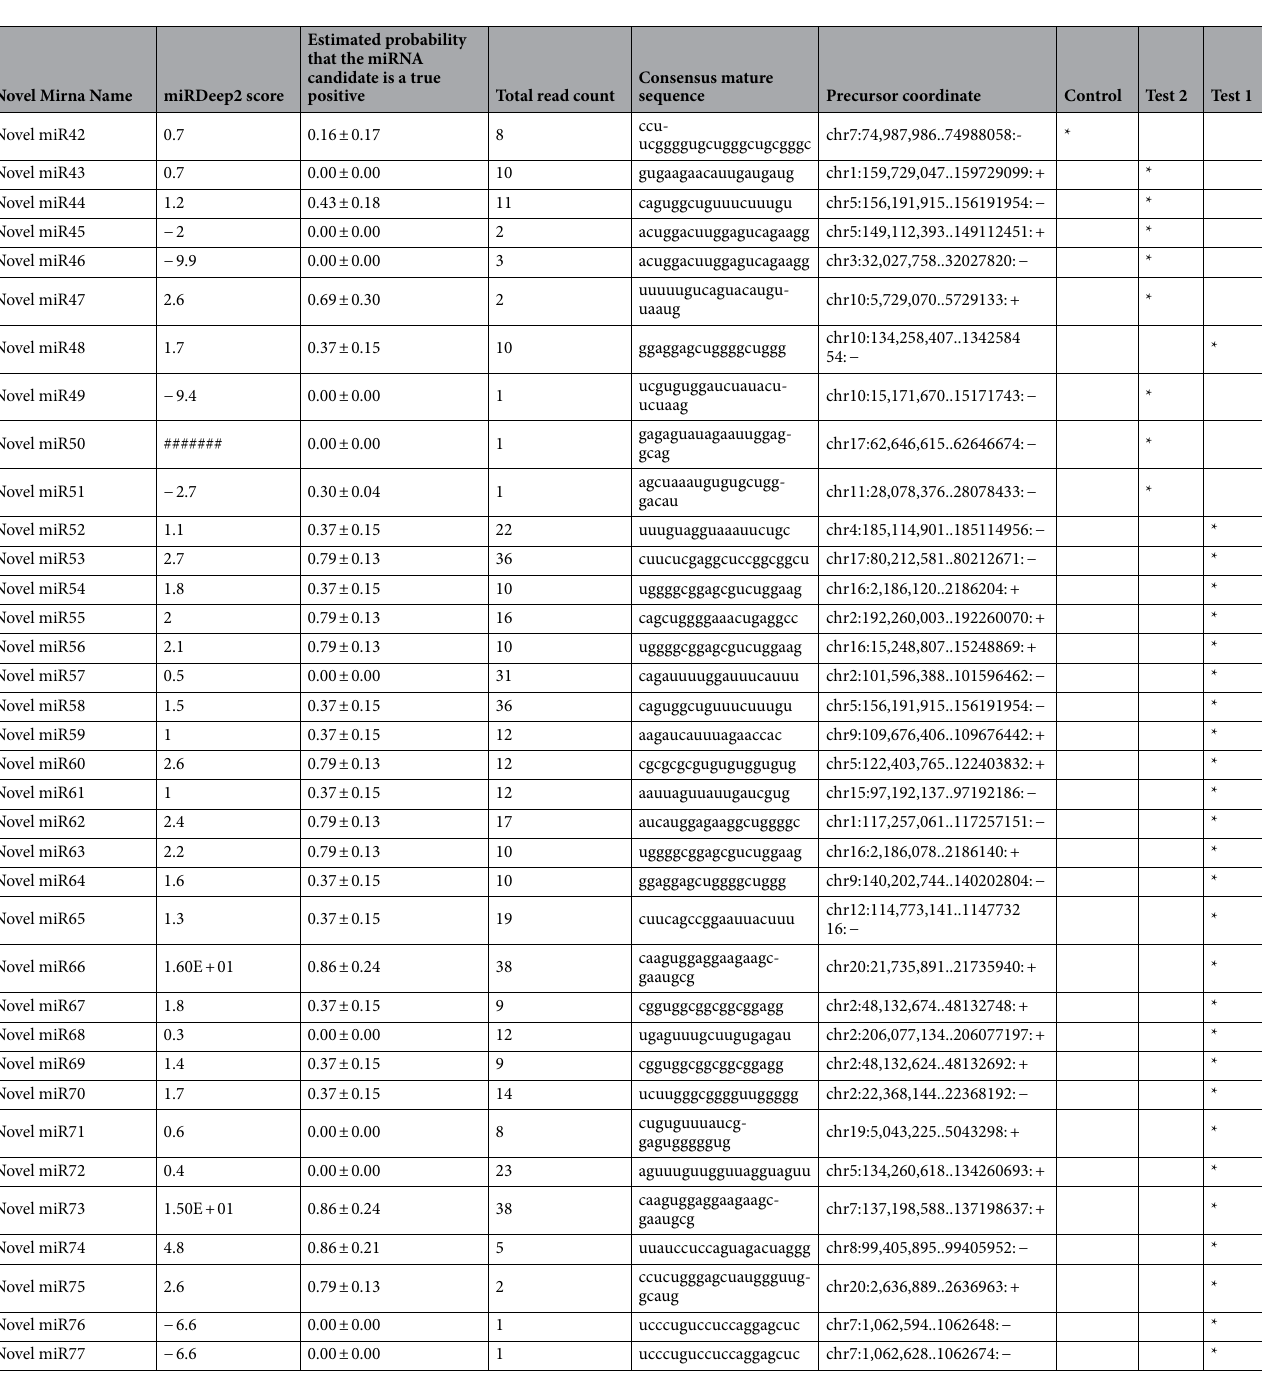
Table 2. List of novel microRNAs and their consensus sequences.